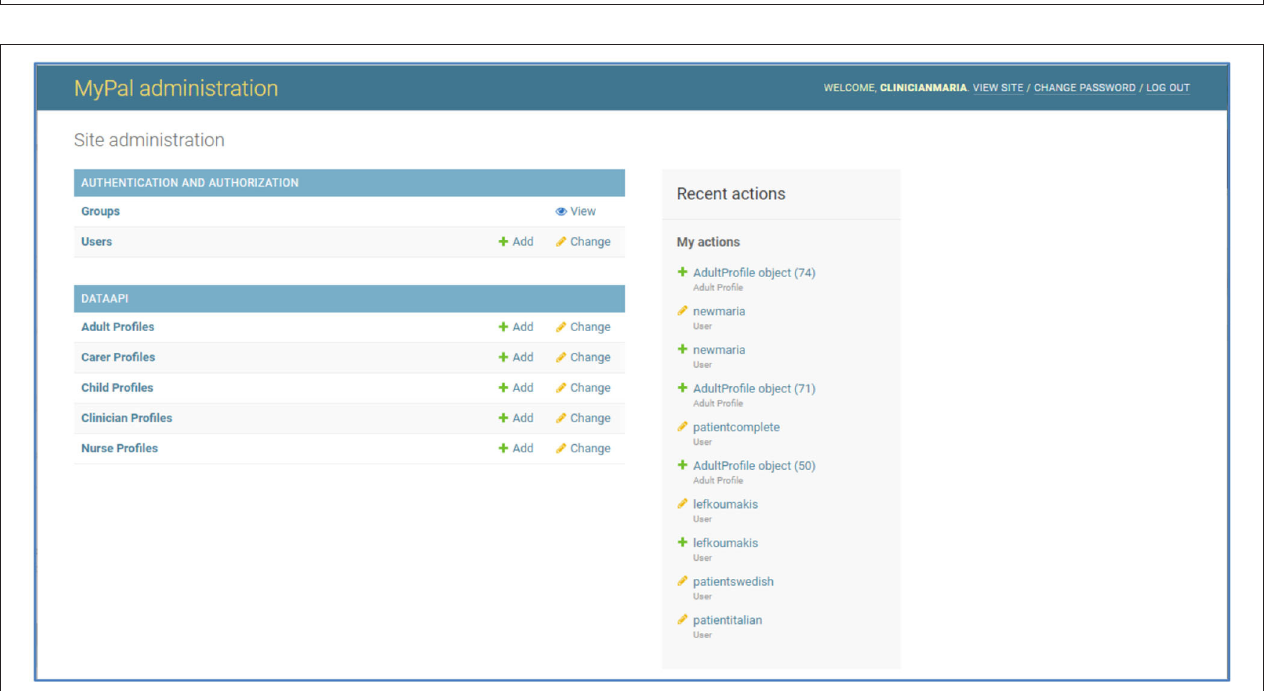
FIGURE 5 | MyPal administrator